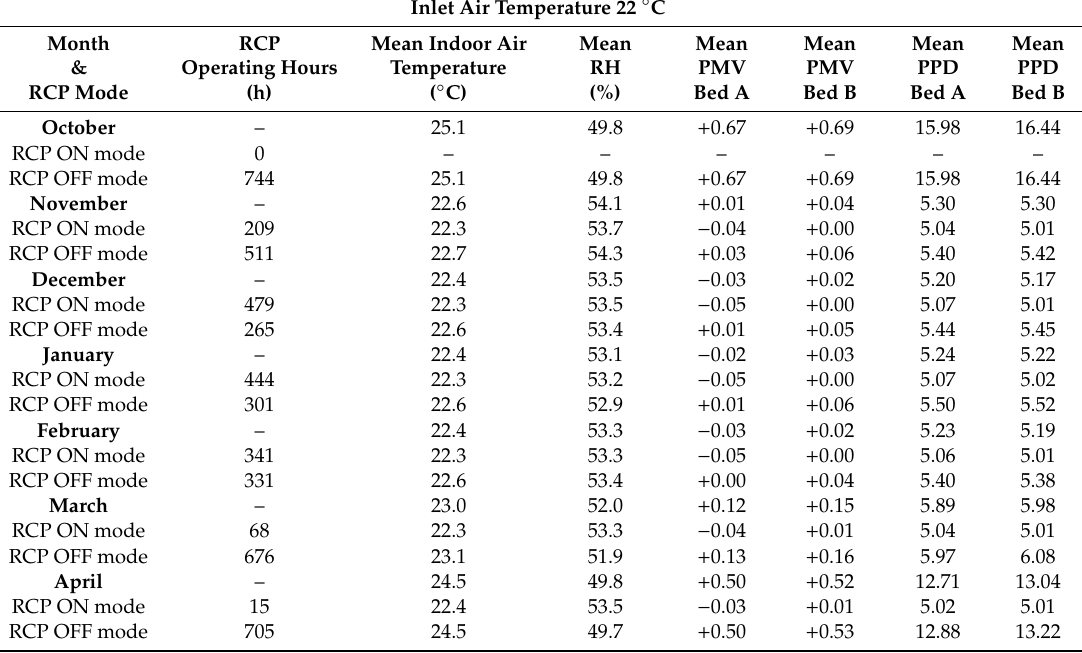
Table 7. Monthly RCP operating hours, mean indoor air temperature, RH, PMV and PPD with inlet air temperature of 22 ◦